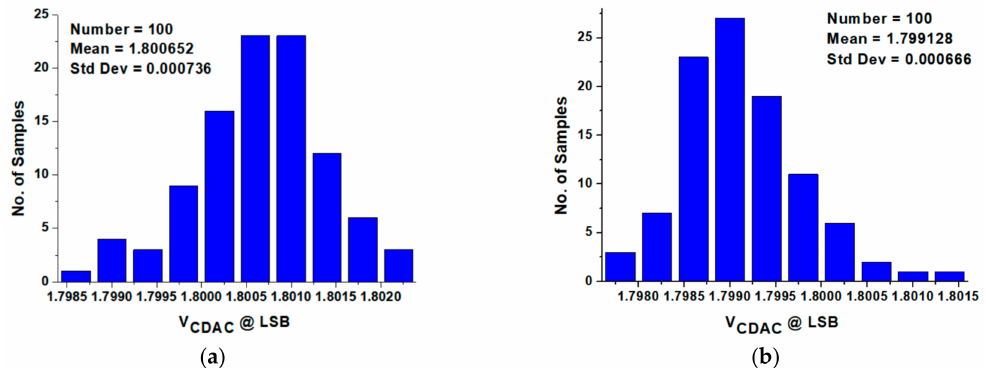
Figure 18. Output voltage of CDAC in Monte Carlo simulation to decide the least significant bit (LSB) for ( a ) all high; ( b ) all low.